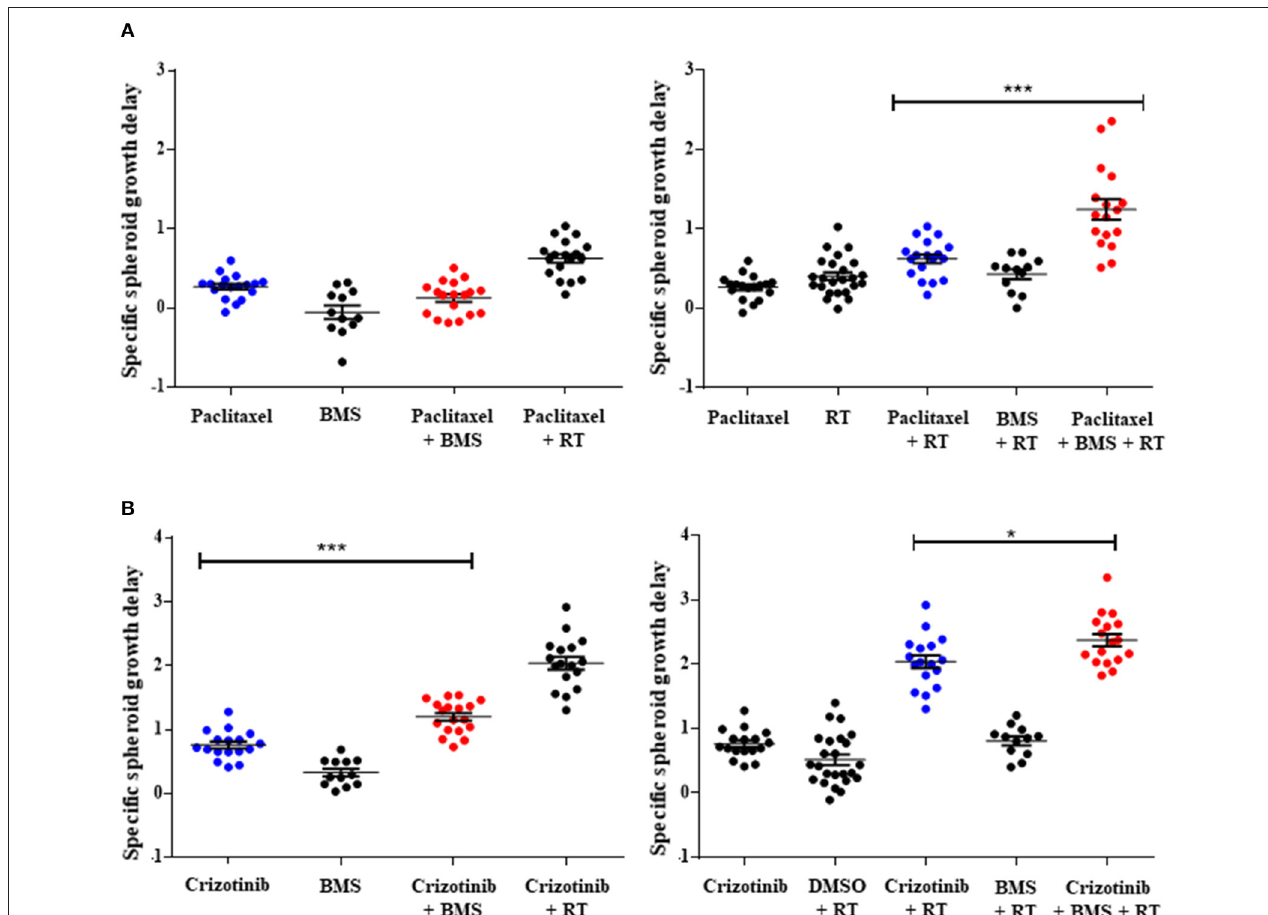
FIGURE 3 | Pan-NOTCH/ γ -secretase inhibitor BMS-906024 delays H1299 multicellular spheroid specific growth in combination treatments. SSGD of multicellular NCI-H1299 spheroids were treated with 2.5nM paclitaxel (A) or 0.4 µ M crizotinib (B) and/or 1 µ M BMS-906024 and/or 2Gy radiation, is shown. Statistical significance of the comparison between single-agent chemotherapy: paclitaxel (A) or crizotinib (B) , vs. chemotherapy plus BMS-906024 (left), or chemoradiation vs. chemoradiation plus BMS-906024 (right) is shown. Spheroid specific spheroid growth delay (SSGD) was calculated as T4xSV treatment – T4xSV control and